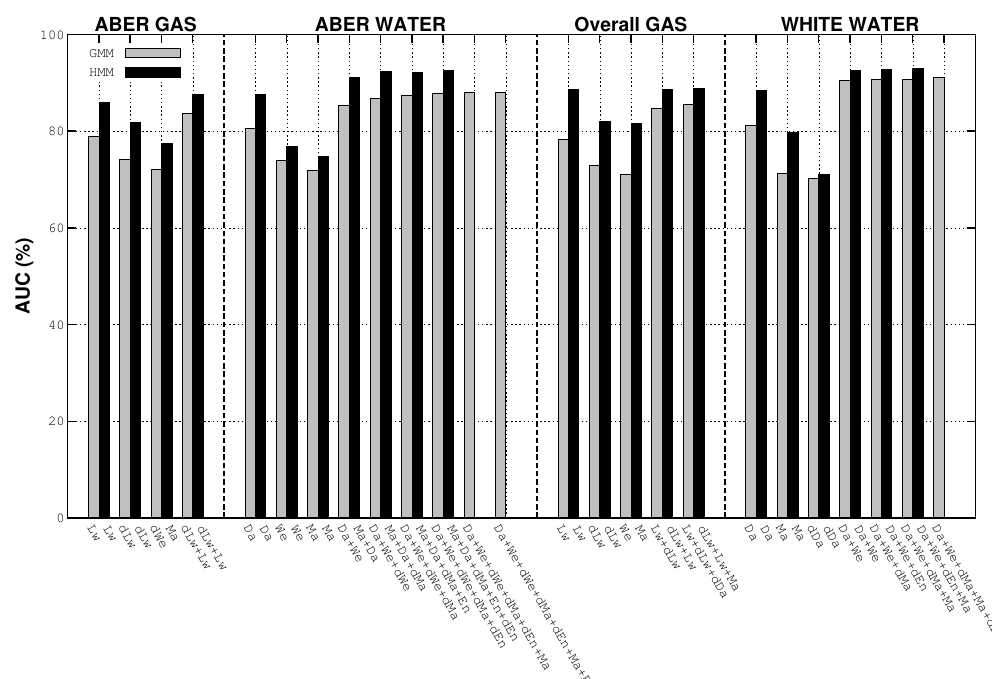
Figure 4. Feature selection steps and corresponding features’ combination until the achievement of the best result for the DFID datasets. In the x-axis are reported the corresponding best features’ combinations for both GMM and